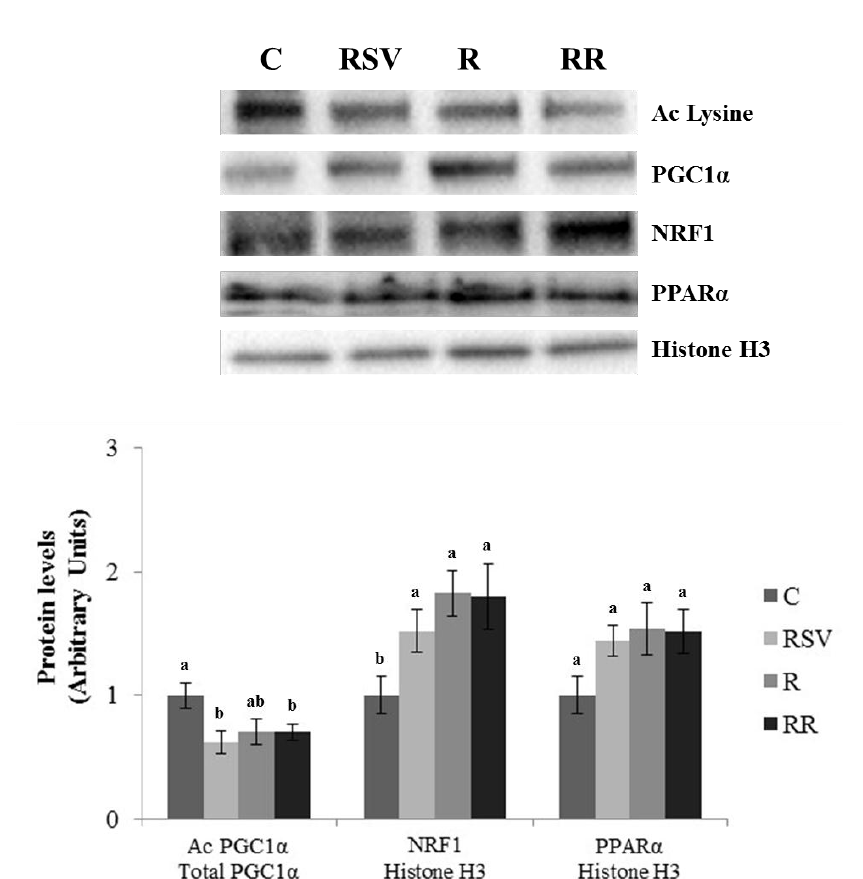
Figure 5. Acetylation ratio of PGC1 α and protein levels of NRF1 and PPAR α in IBAT of rats fed an obesogenic diet for 6 weeks and then shifted to a standard diet (C), or standard diet supplemented with resveratrol (RSV), or submitted to energy restriction and fed a standard diet (R), or submitted to energy restriction and fed a standard diet supplemented with resveratrol (RR) ( n = 9/group) for additional 6 weeks. Values are represented as means ± SEM. Differences among groups were determined by using one-way ANOVA followed by Newman–Keuls post hoc test. Values not sharing a common letter are significantly different ( p < 0.05). PGC1 α : peroxisome proliferator-activated receptor gamma coactivator 1-alpha, NRF1: nuclear respiratory factor 1, PPAR α : peroxisome proliferator-activated receptor alpha, IBAT: interscapular brown adipose tissue.